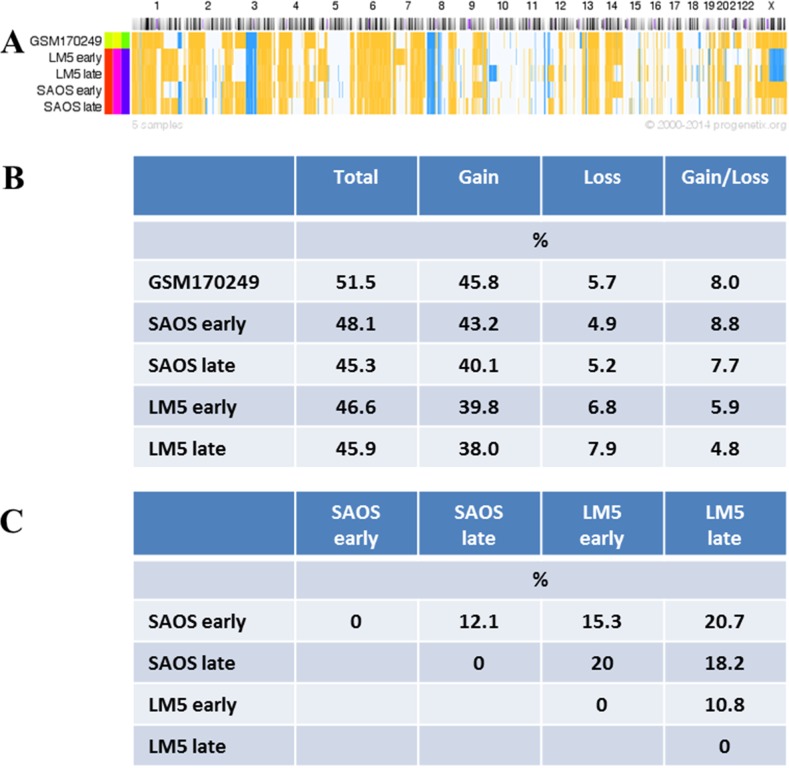
Copy number (CN) aberrations in the SAOS/LM5 cell system.(A) CN gains (yellow) and losses (blue) compared to normal diploid human genome were analyzed in SAOS and LM5 cells of early and late passages and compared to published data of SAOS cells (GSM170249; [25]) using arrayMap as described in Methods. (B) Statistics of CN gains and losses compared to normal human diploid genome. (C) Total CN differences between early and late passages of SAOS and LM5 cells.